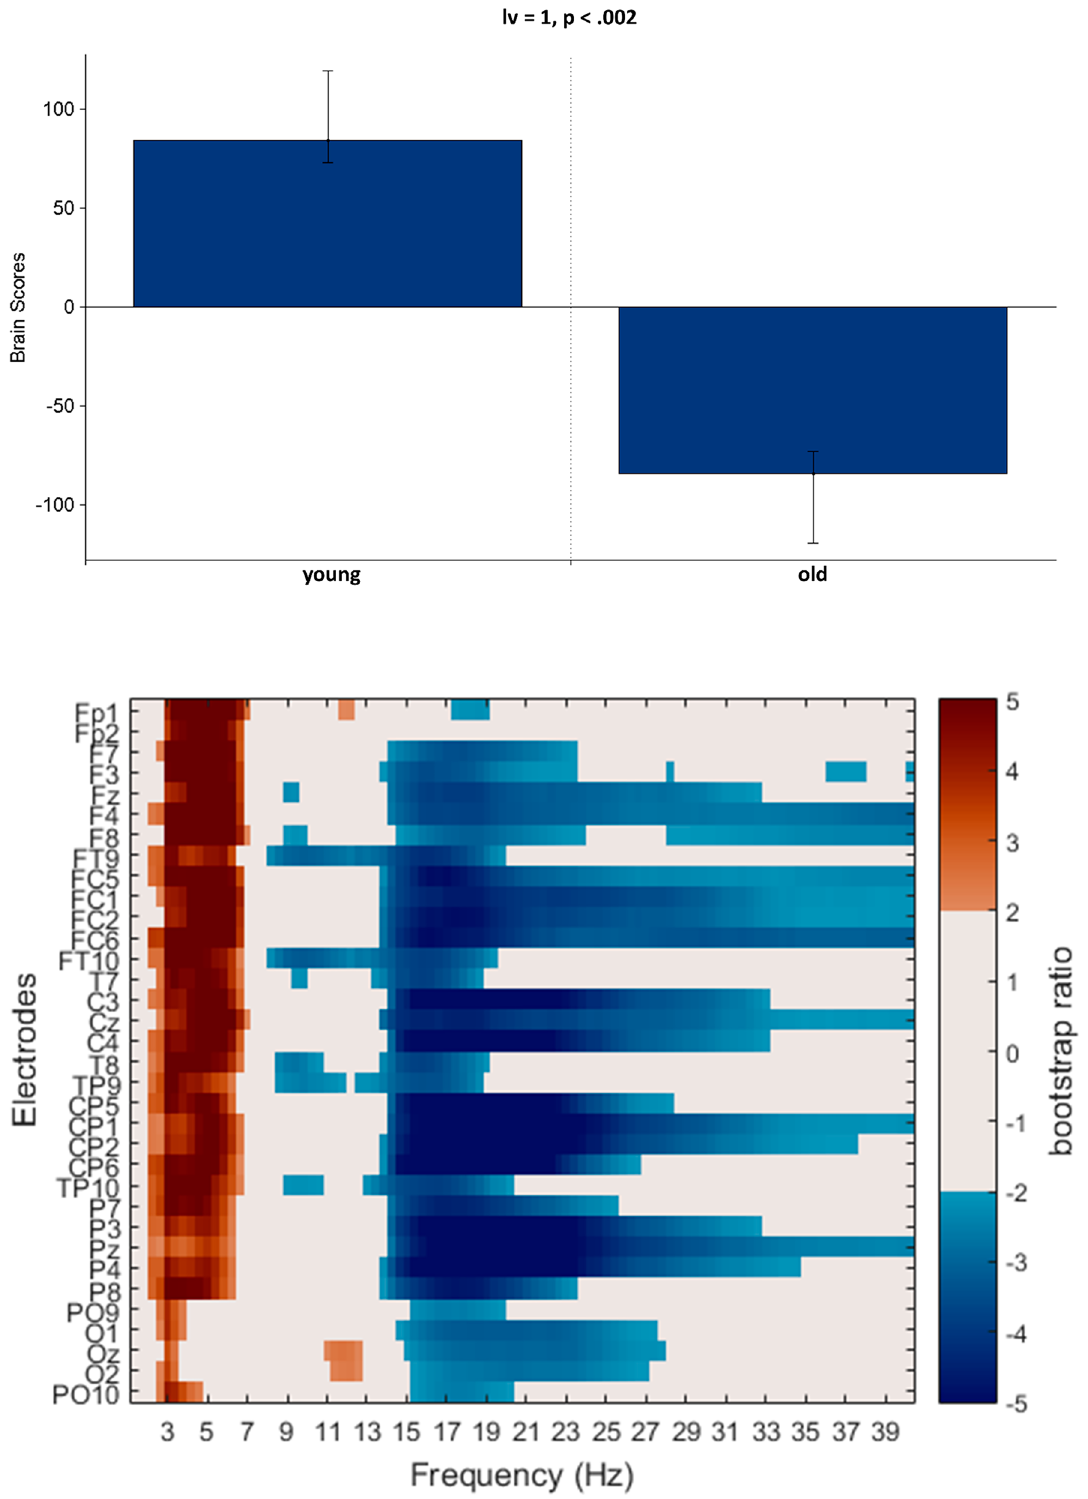
Figure 5. PLS analysis results for the general aging effect on SPD (using the pre-training resting state in our two age-groups). (Top) The bar graph depicts the contrast between age-groups that was significantly expressed across electrodes and frequencies as determined by permutation tests, with erros bars denoting 95% confidence intervals. (Bottom) The bootstrap ratio map) illustrates the electrodes and frequencies at which the contrast displayed in the bar graphs was most stable. Values represent the ratio of the individual electrode weights and the bootstrap-derived standard error (roughly z scores, thresholded at 2.0 which corresponds approximately to p < 0.05). Positive values are plotted in warm colours and indicate frequencies and electrodes showing decreases from young to old age-group in resting state SPD. Negative values are plotted in cool colours and denote increases from young to old age-group in resting state